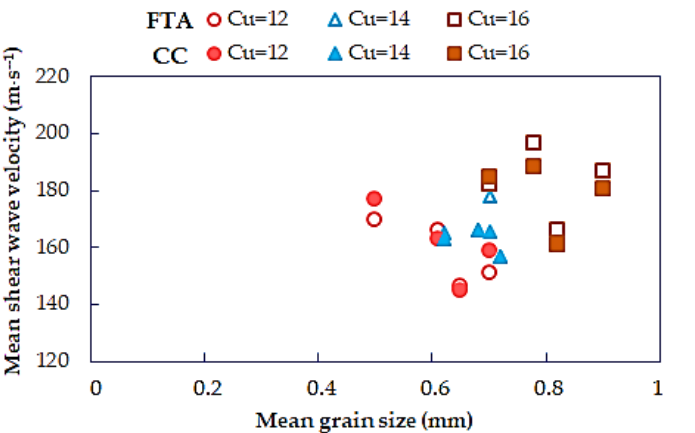
Figure 16. Effect of mean grain size ( d 50 ) on mean shear wave velocity for sands from the first time of arrival method and cross-correlation method.